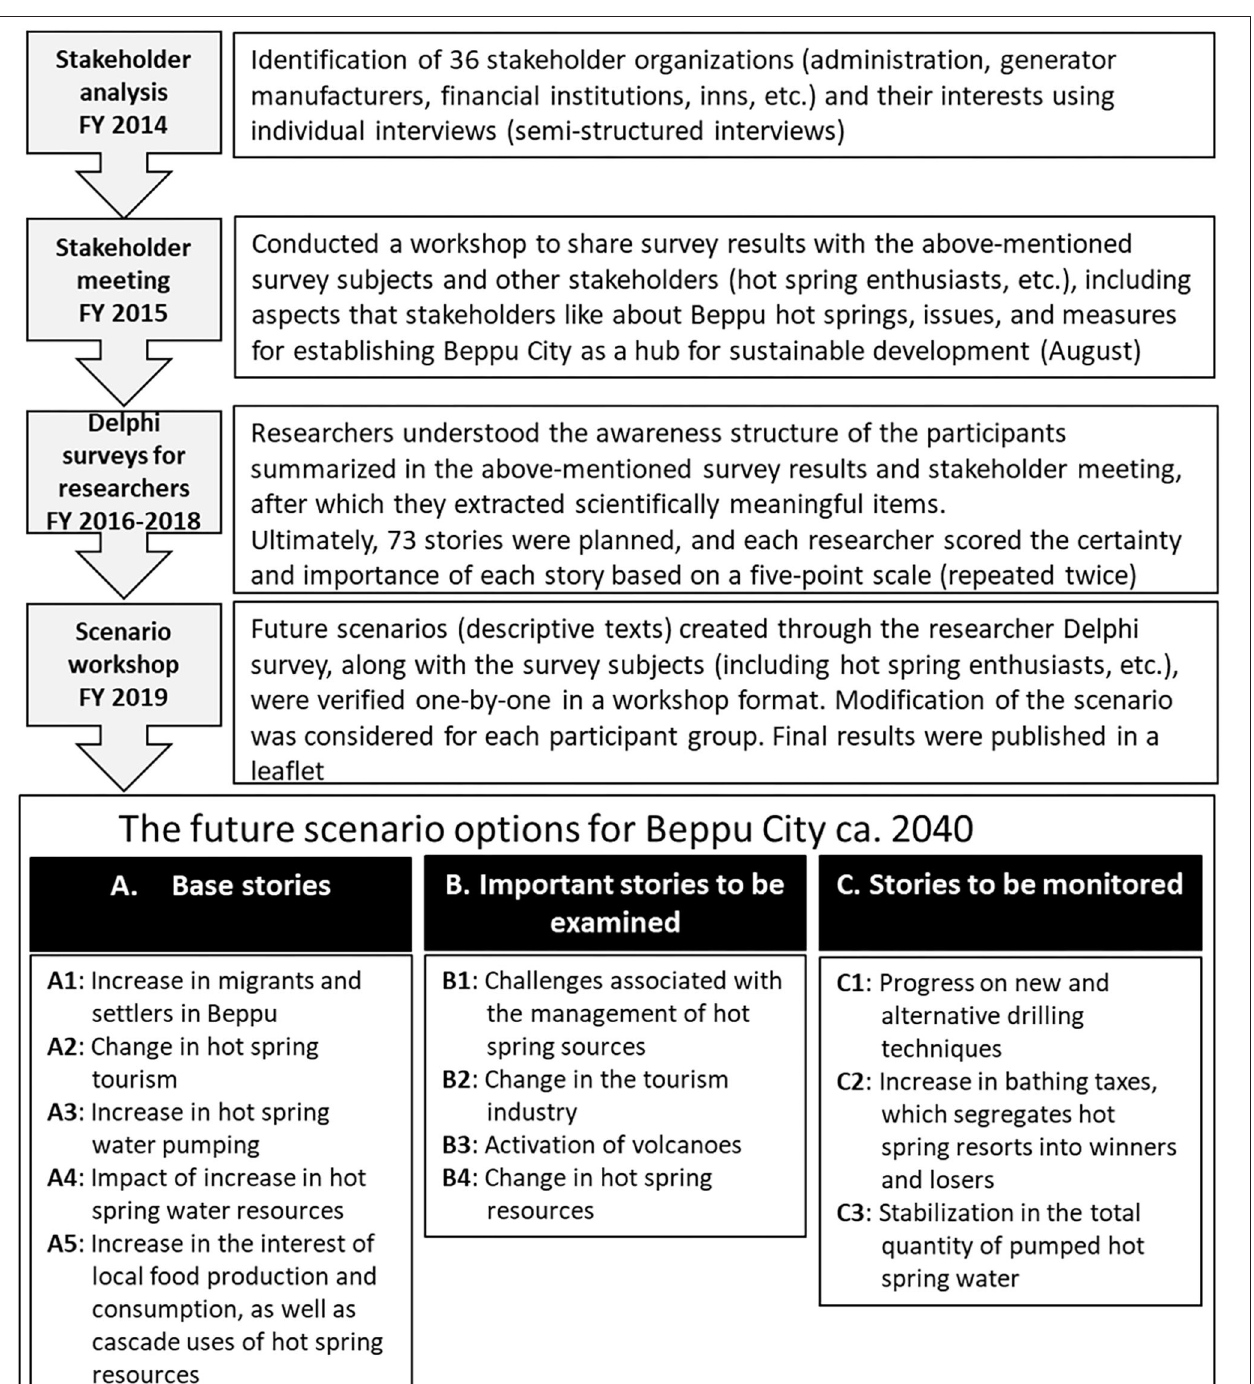
FIGURE 8 | Procedure for building future scenarios in Beppu City and future scenario options for ca. 2040.